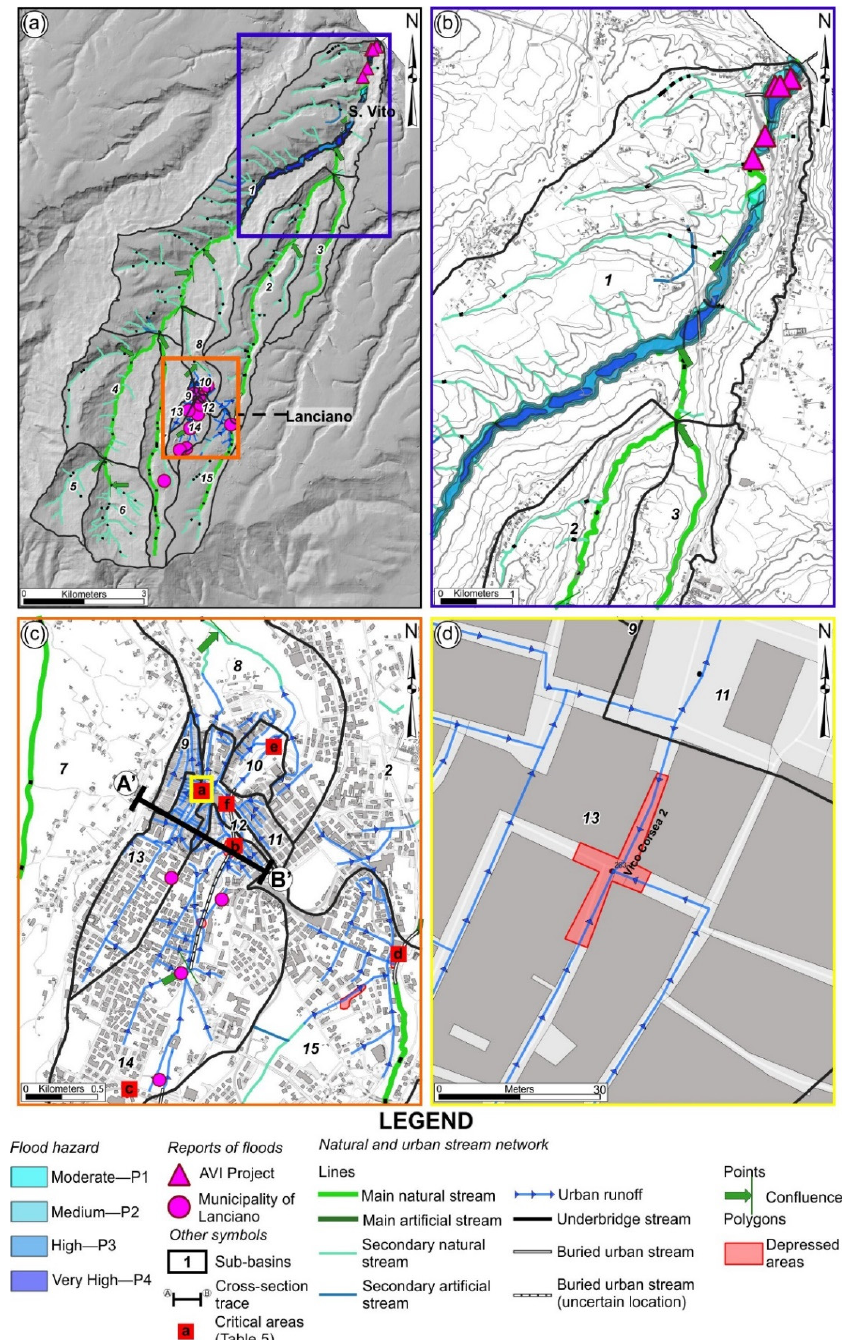
Figure 10. Data used for the flood critical areas map through the geomorphology-based matrix. ( a ) Flood hazard [58], reports of floods [59,72], and the natural and urban stream network of the Feltrino Stream basin. ( b ) Enlarged view of the Feltrino Stream sea mouth (purple box in Figure 10a). ( c ) Natural and urban stream network of the municipality of Lanciano (orange box in Figure 10a). ( d ) The Vico Corsea 2 critical area, in the historic center of Lanciano (yellow box in Figure 10c). Critical areas a and c (in the red boxes) represent the sites of Figure 9a,b, respectively.